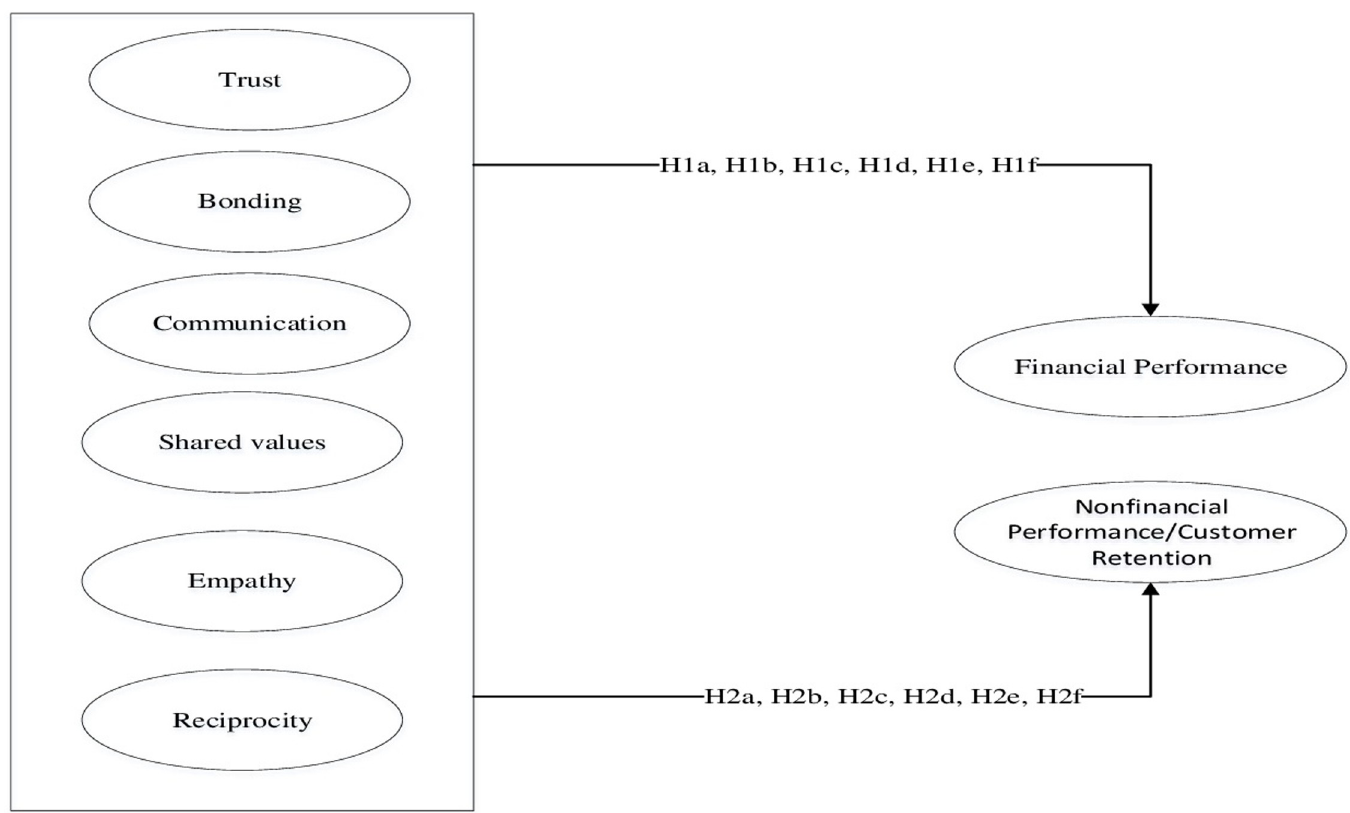
Fig 1. Conceptual